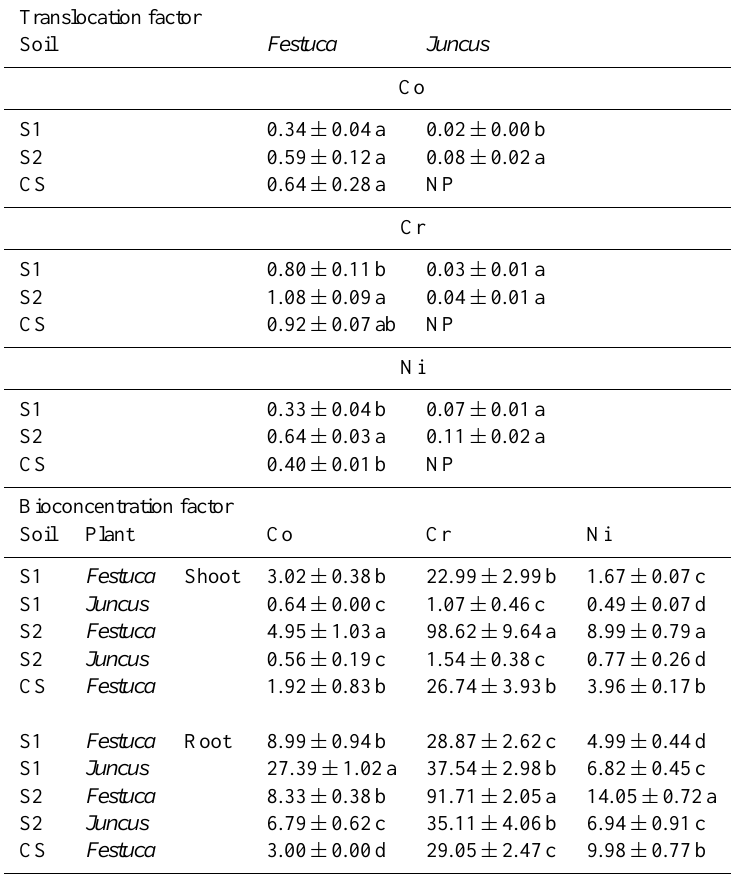
Table 6. Translocation and bioconcentration factors (mean values and standard